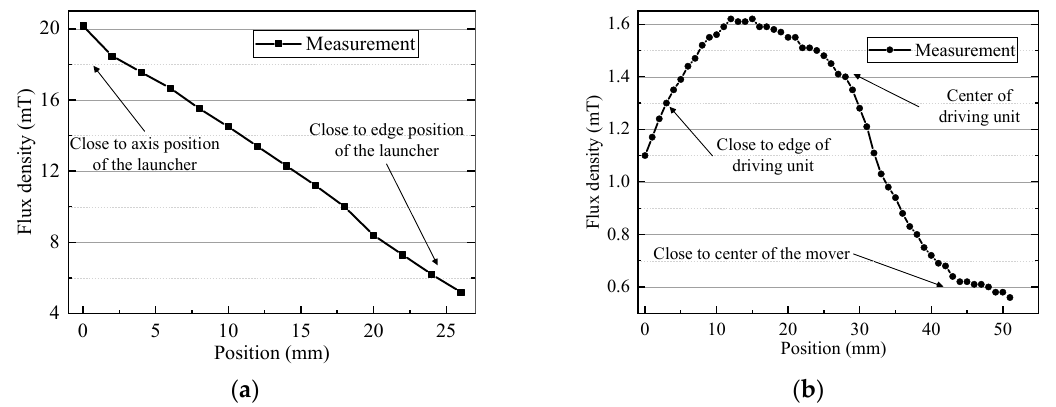
Figure 17. Magnetic field leakage at the key position close to the CubeSat: ( a ) ejection unit of the launcher and ( b ) driving unit of the conveying platform.